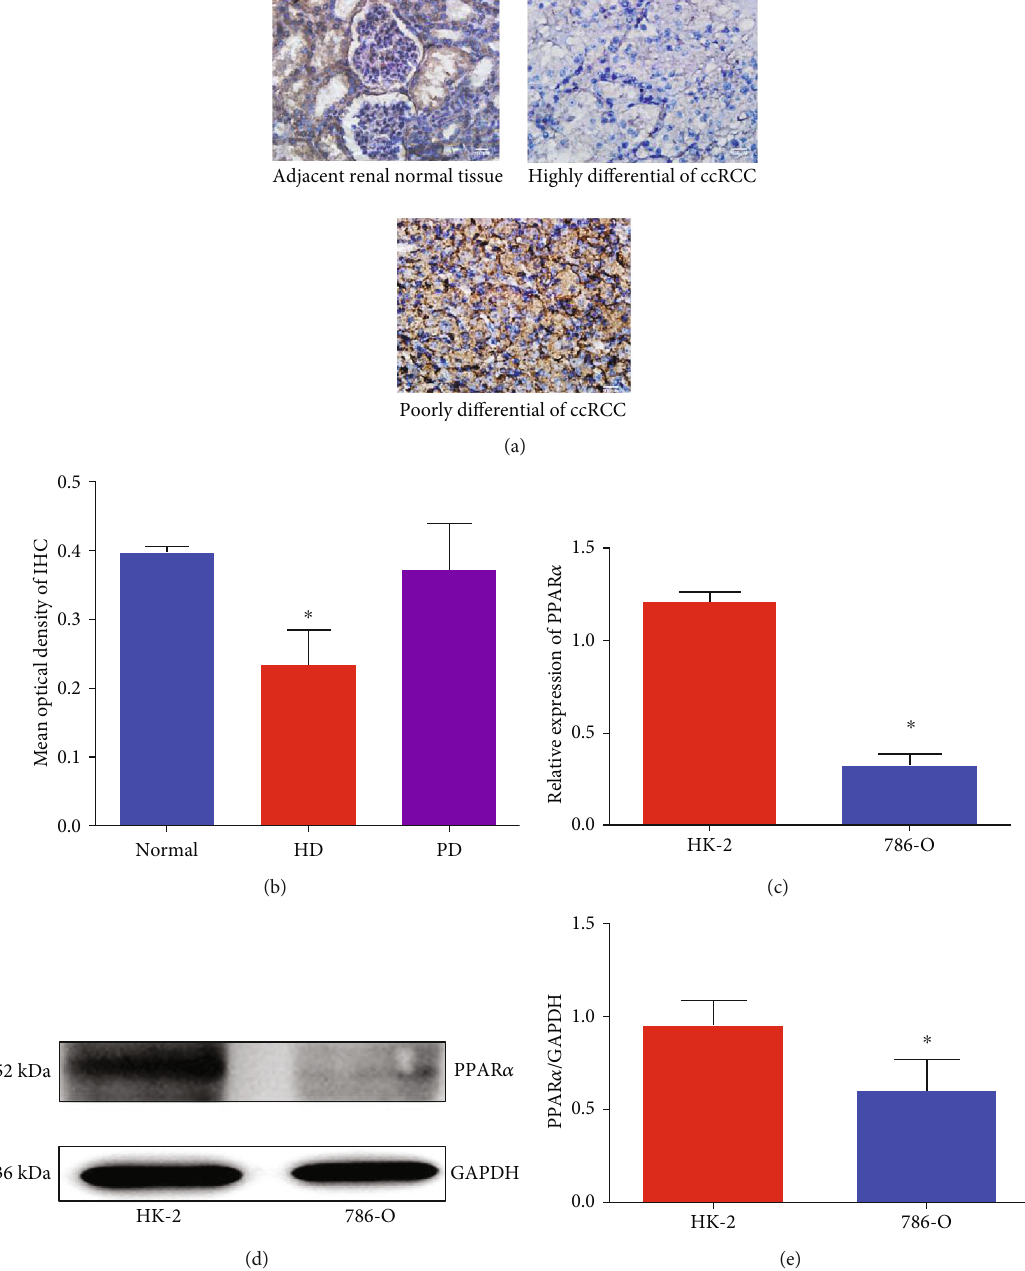
Figure 1: PPAR α was poorly expressed in high di ff erentiation of the ccRCC tissues and 786-O cell line, but highly expressed in poorly di ff erentiation of ccRCC tissues. (a) IHC staining for PPAR α among di ff erent grades of di ff erentiation in ccRCC tissues when compared with the adjacent normal tissues. (b) Mean OD of IHC staining (normal: adjacent normal tissues; HD: highly di ff erentiation; PD: poorly di ff erentiation). (c) The expression of PPAR α mRNA in 786-O and HK-2 cells by qRT-PCR normalized by GAPDH. (d) Western blotting for determining the expression of PPAR α protein in 786-O and HK-2 cells. (e) Semiquanti fi cation of PPAR α in 786-O and HK-2 cells normalized by GAPDH ( n = 3 , unpaired Student ’ s t -test, ∗ P < 0 : 05